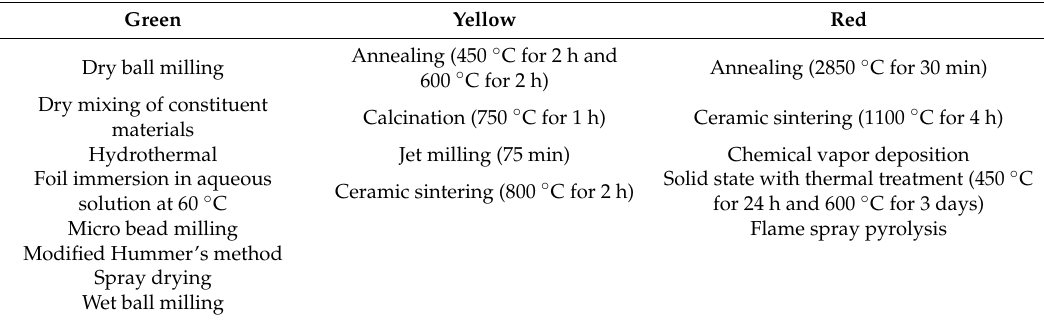
Table A3. Overview of energy of synthesis